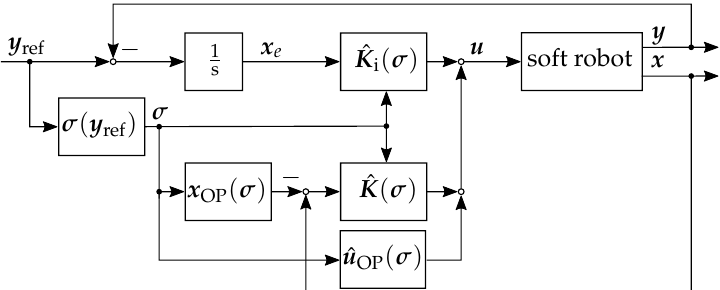
Figure 7. Tip position and spanned workspace of the LQI controller.